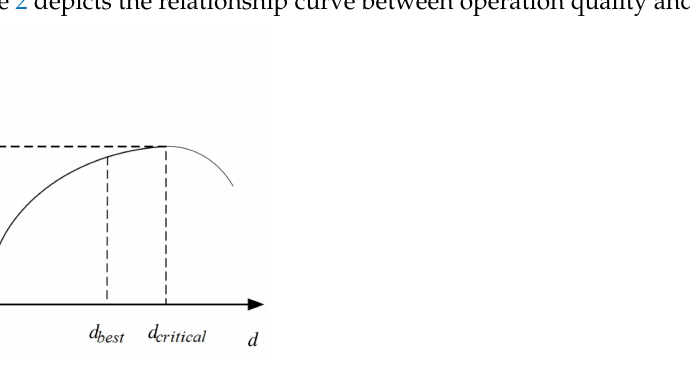
Figure 2. The relationship between operation quality and operation